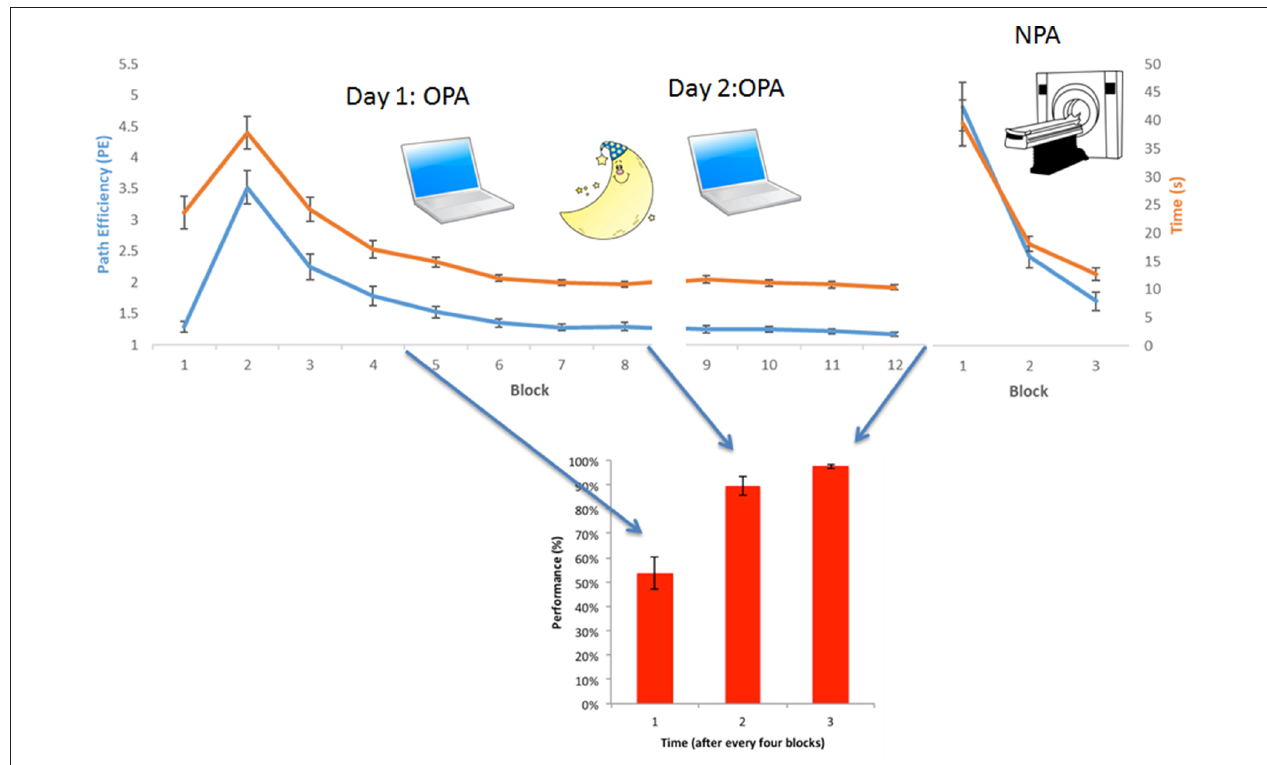
FIGURE 2 | Behavioral results OPA-training and NPA-learning. Average group-level behavioral results. (Upper) Normalized path length (or Path efficiency, PE, in blue) and time needed to find the cue (in orange) for each block, both during OPA and NPA learning blocks. (Lower) Associative wallpaper-face memory was tested after every fourth OPA block. OPA, NPA and associative performance significantly improved over blocks, revealing robust learning. Importantly, NPA learning (NPA blocks 2 and 3) was significantly faster than OPA learning (OPA blocks 2 and 3), as supported by a significant condition × block interaction.